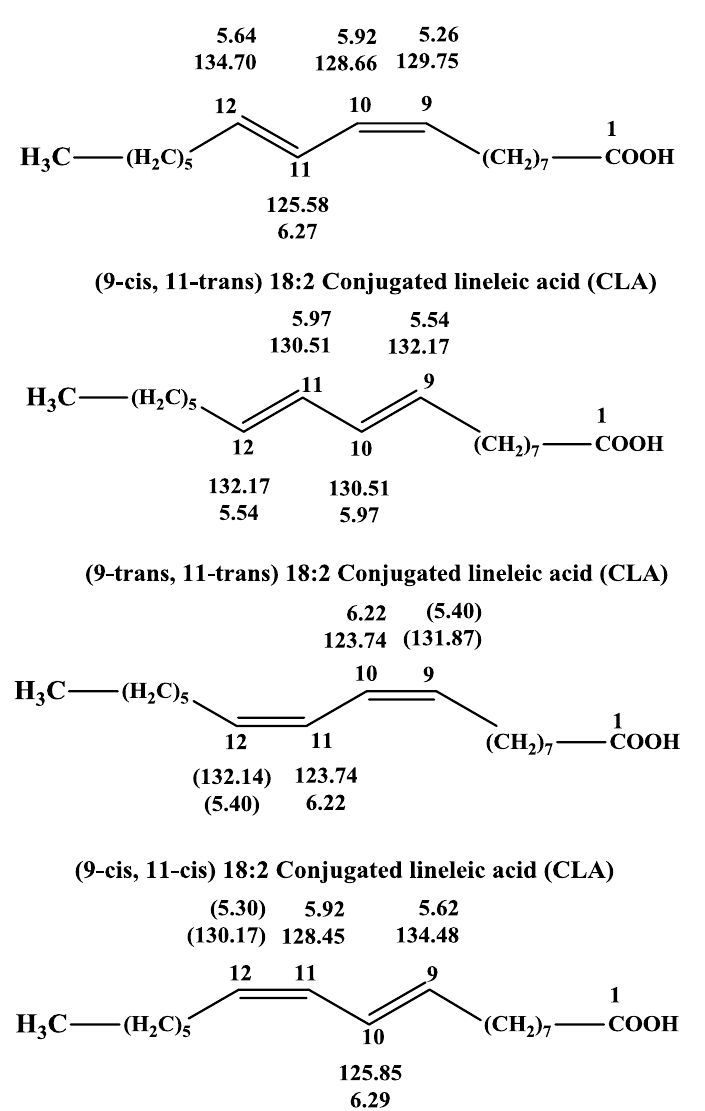
Figure 25. 1 H- and 13 C-NMR chemical shifts, in ppm, of C9 to C12 carbons and their attached protons for the four geometric isomers of 18:2 CLA. Adopted, with permission, from [56]. Copyright 2014, Elsevier B.V.